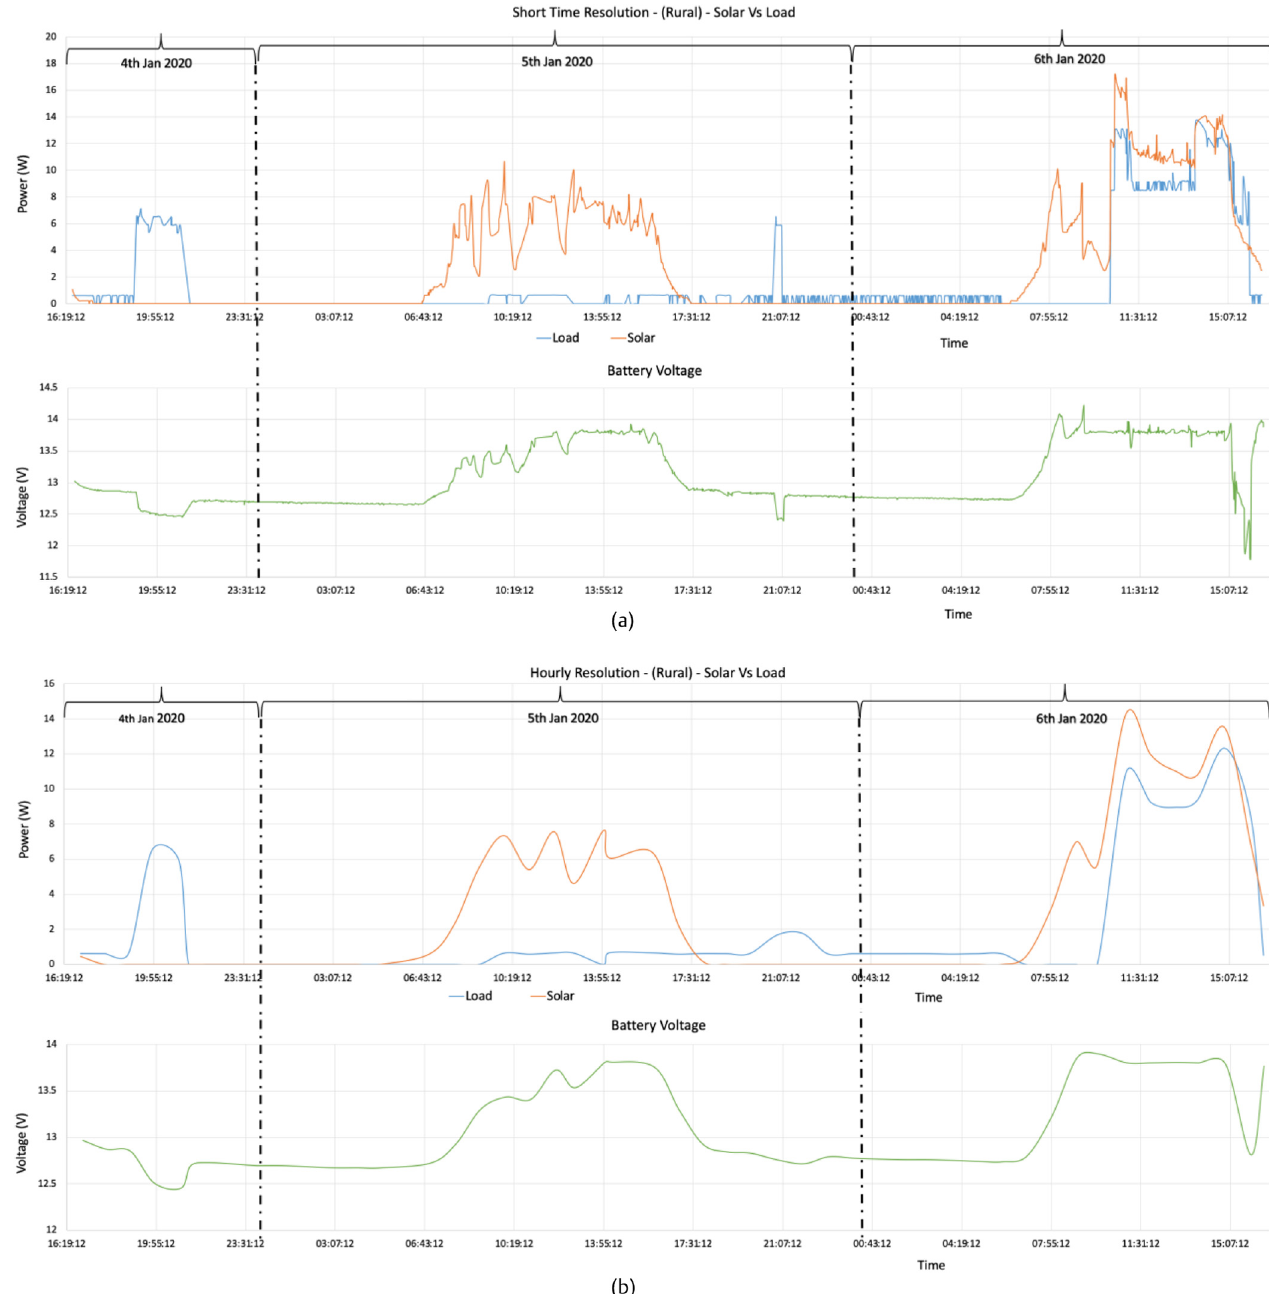
Fig. 2. Example of daily solar data for 4th Jan, 5th Jan and 6th Jan at the Rural location. (a) For short time resolution (approx. 5-minute); (b) For hourly